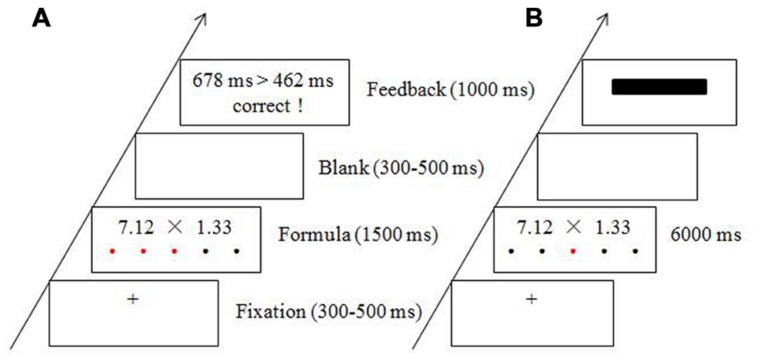
Experimental procedure and sample materials for the stress condition (A) and the control condition (B).